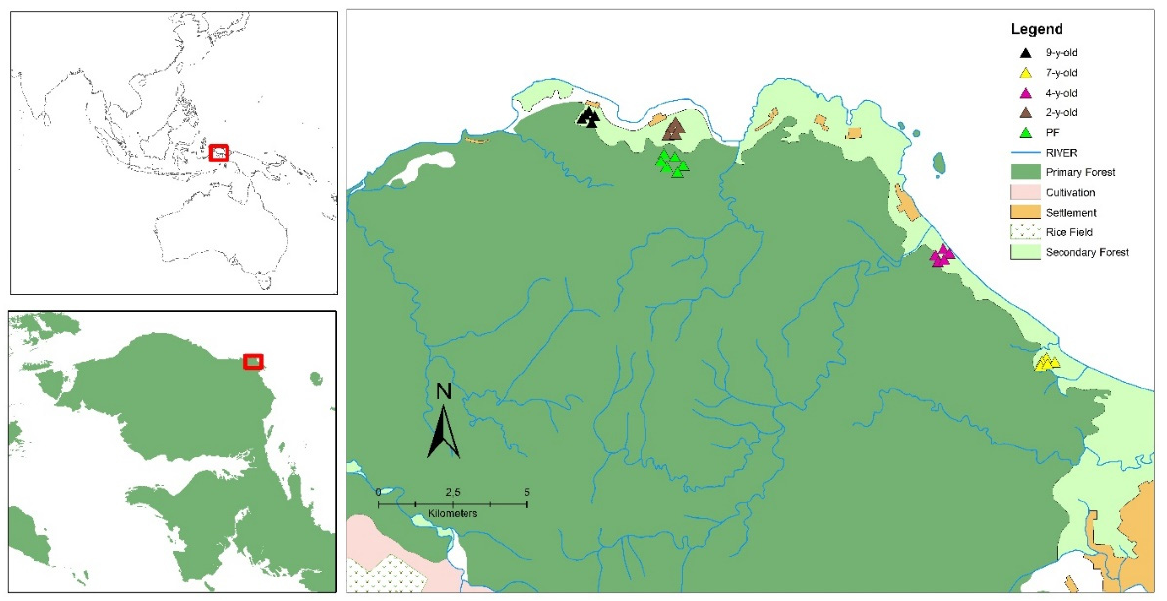
Figure 1. Location of the research in lowland evergreen primary forest (PF) and two- to nine-years-old post-swidden fallow forests in coastal areas of north Manokwari, West Papua, Indonesia.